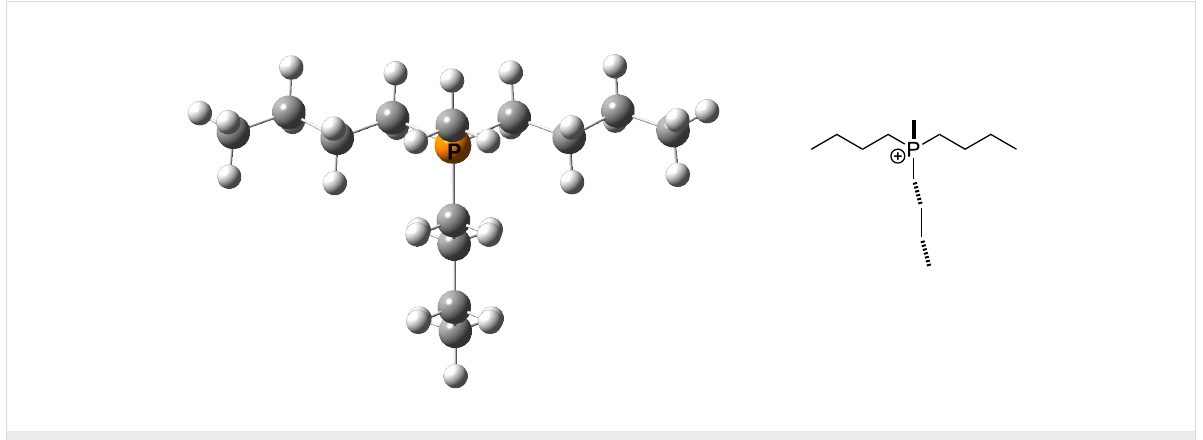
Figure 16: The structure of the energetically best conformations of 120 Me.